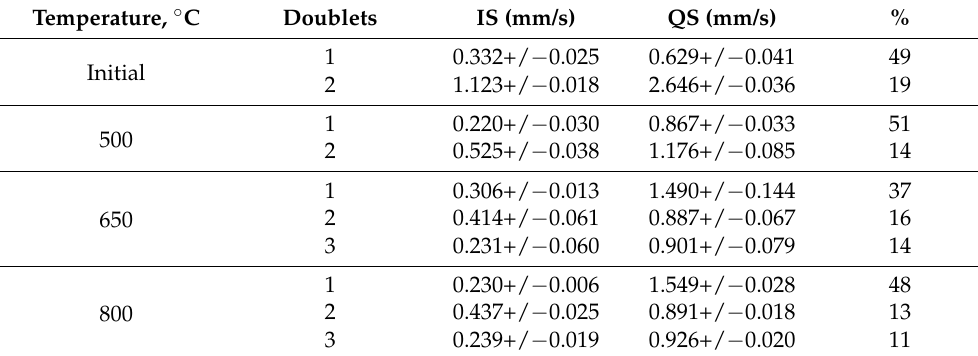
Figure 2. Mössbauer spectra of samples of the MF series. Table 2. Parameters of Mössbauer spectroscopy of the MF series